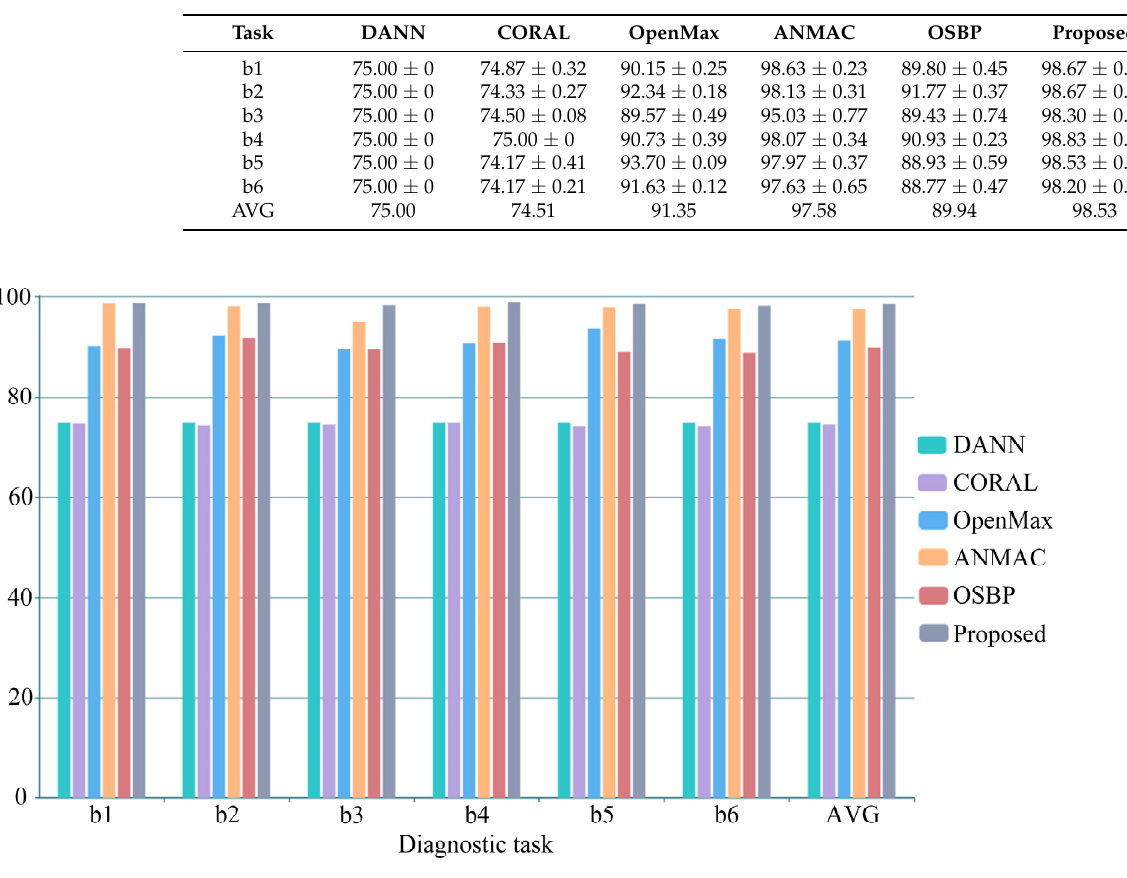
Figure 6. The diagnosis performance comparisons in the CWRU